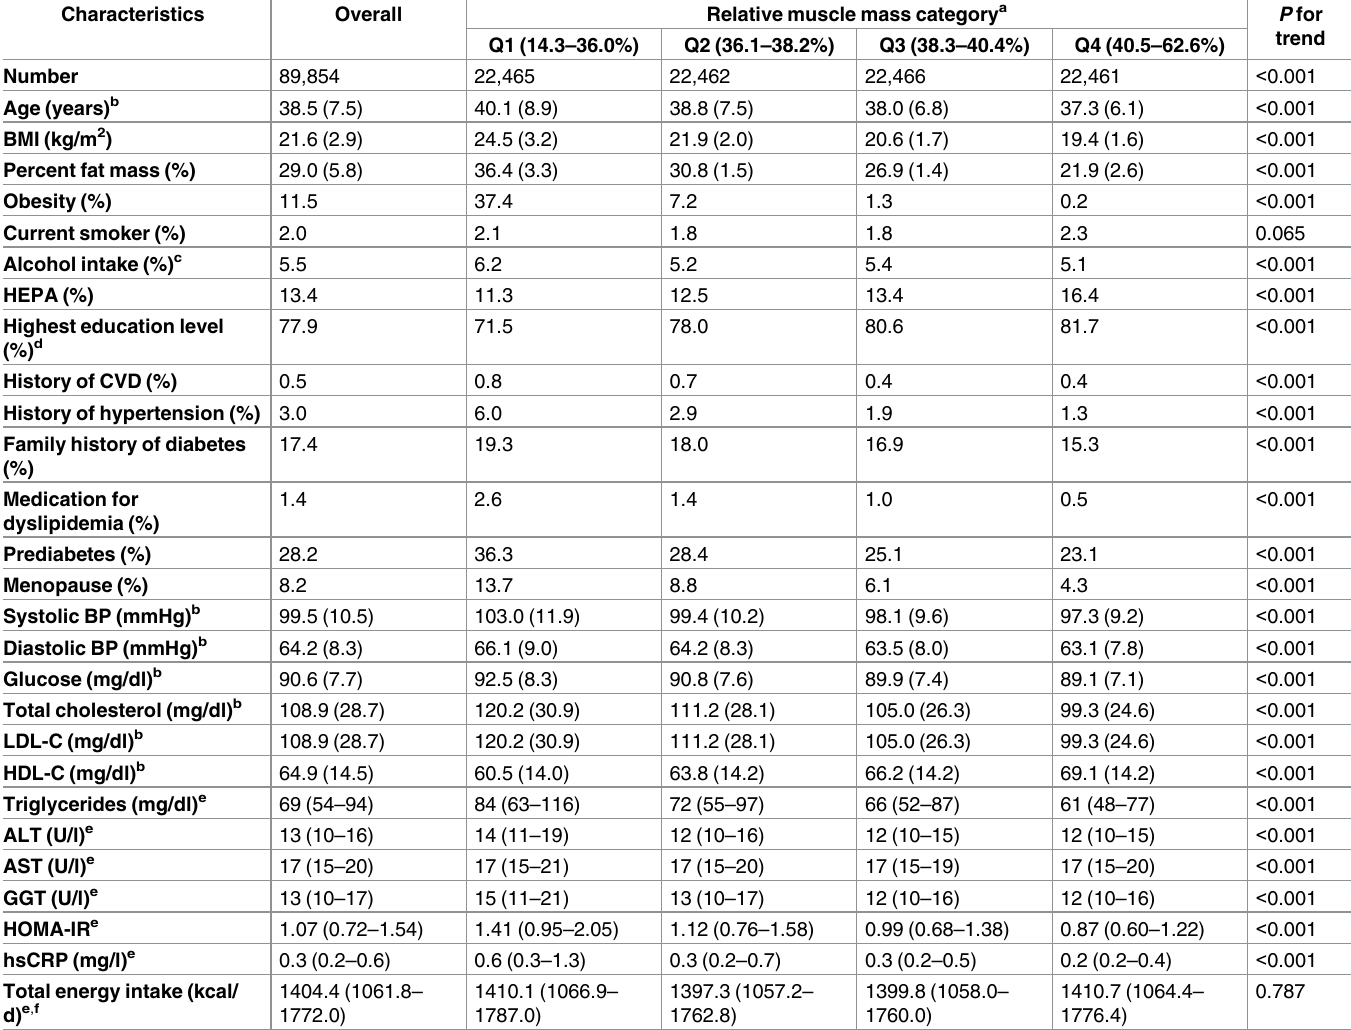
Table 2. Baseline characteristics: Relative muscle mass of female